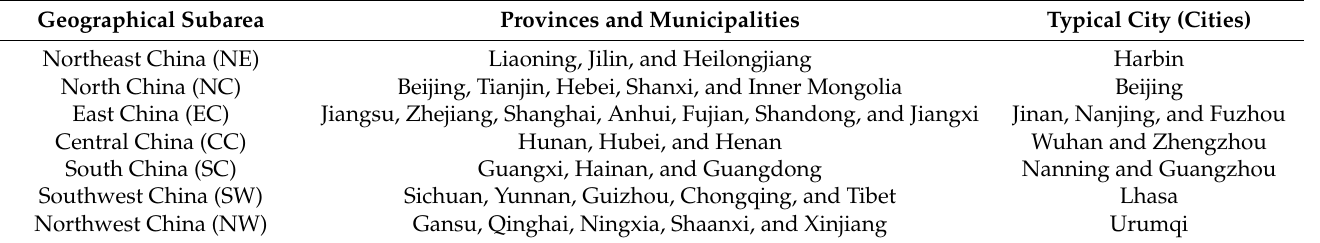
Table 1. Seven geographic regions and 11 typical